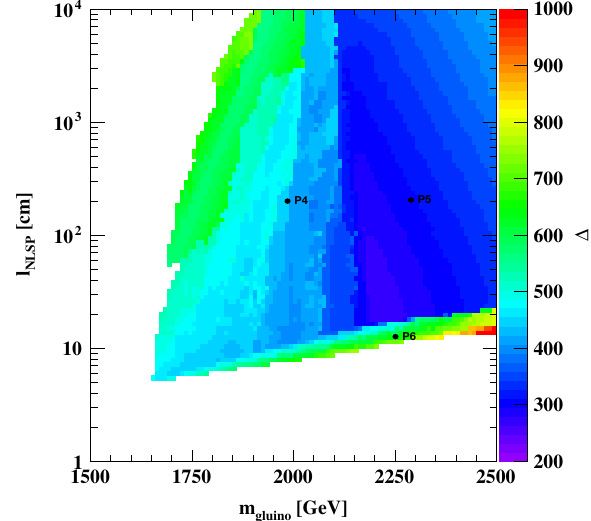
Fig. 5 The same as in Figs. 1 and 2, but for the DGSU model and without applying constraints from LHC sparticle searches. Also shown are the benchmark P4–P6 of Table 1